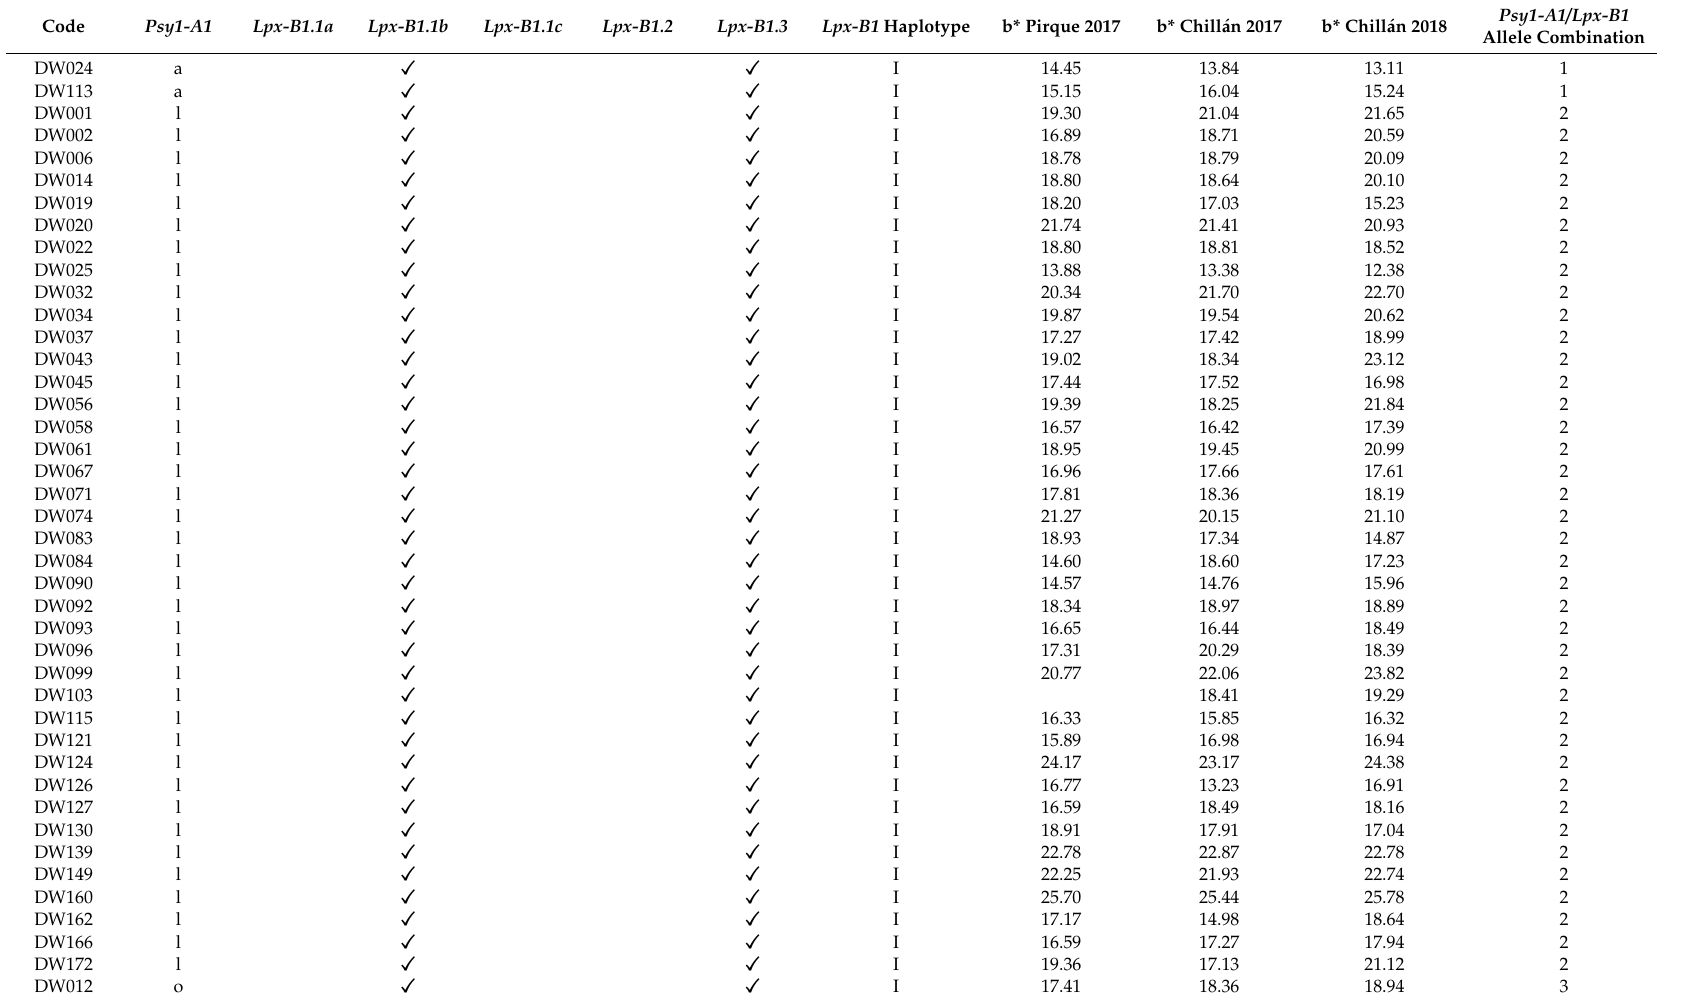
Table 3. Molecular characterization for Phytoene synthase 1 ( Psy1-A1 ) and Lipoxygenase 1 ( Lpx-B1 ) , and yellow index value of the genotypes in the Mediterranean panel. See Table 8 for code